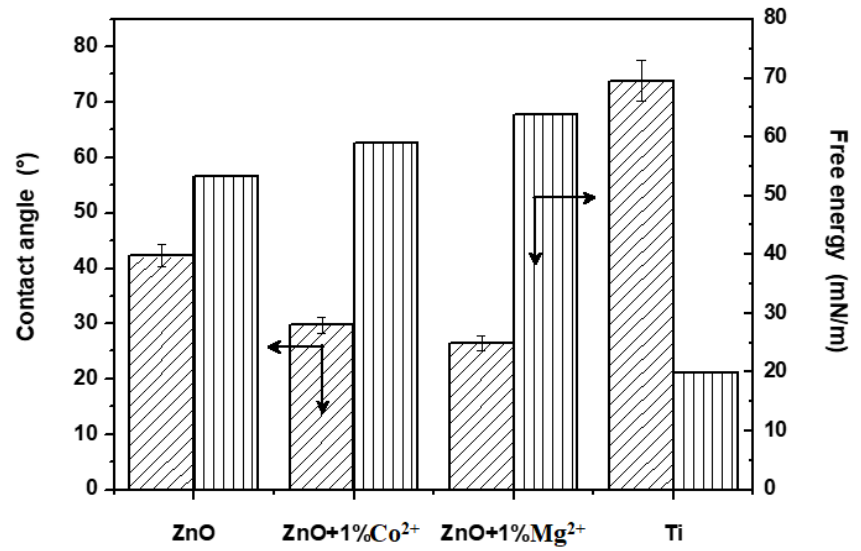
Figure 6. The contact angle and free energy for TiAlV alloy substrate and undoped and Co 2+ /Mg 2+ doped ZnO films coatings on that, at thermally treated at 600 °C for 2 h.